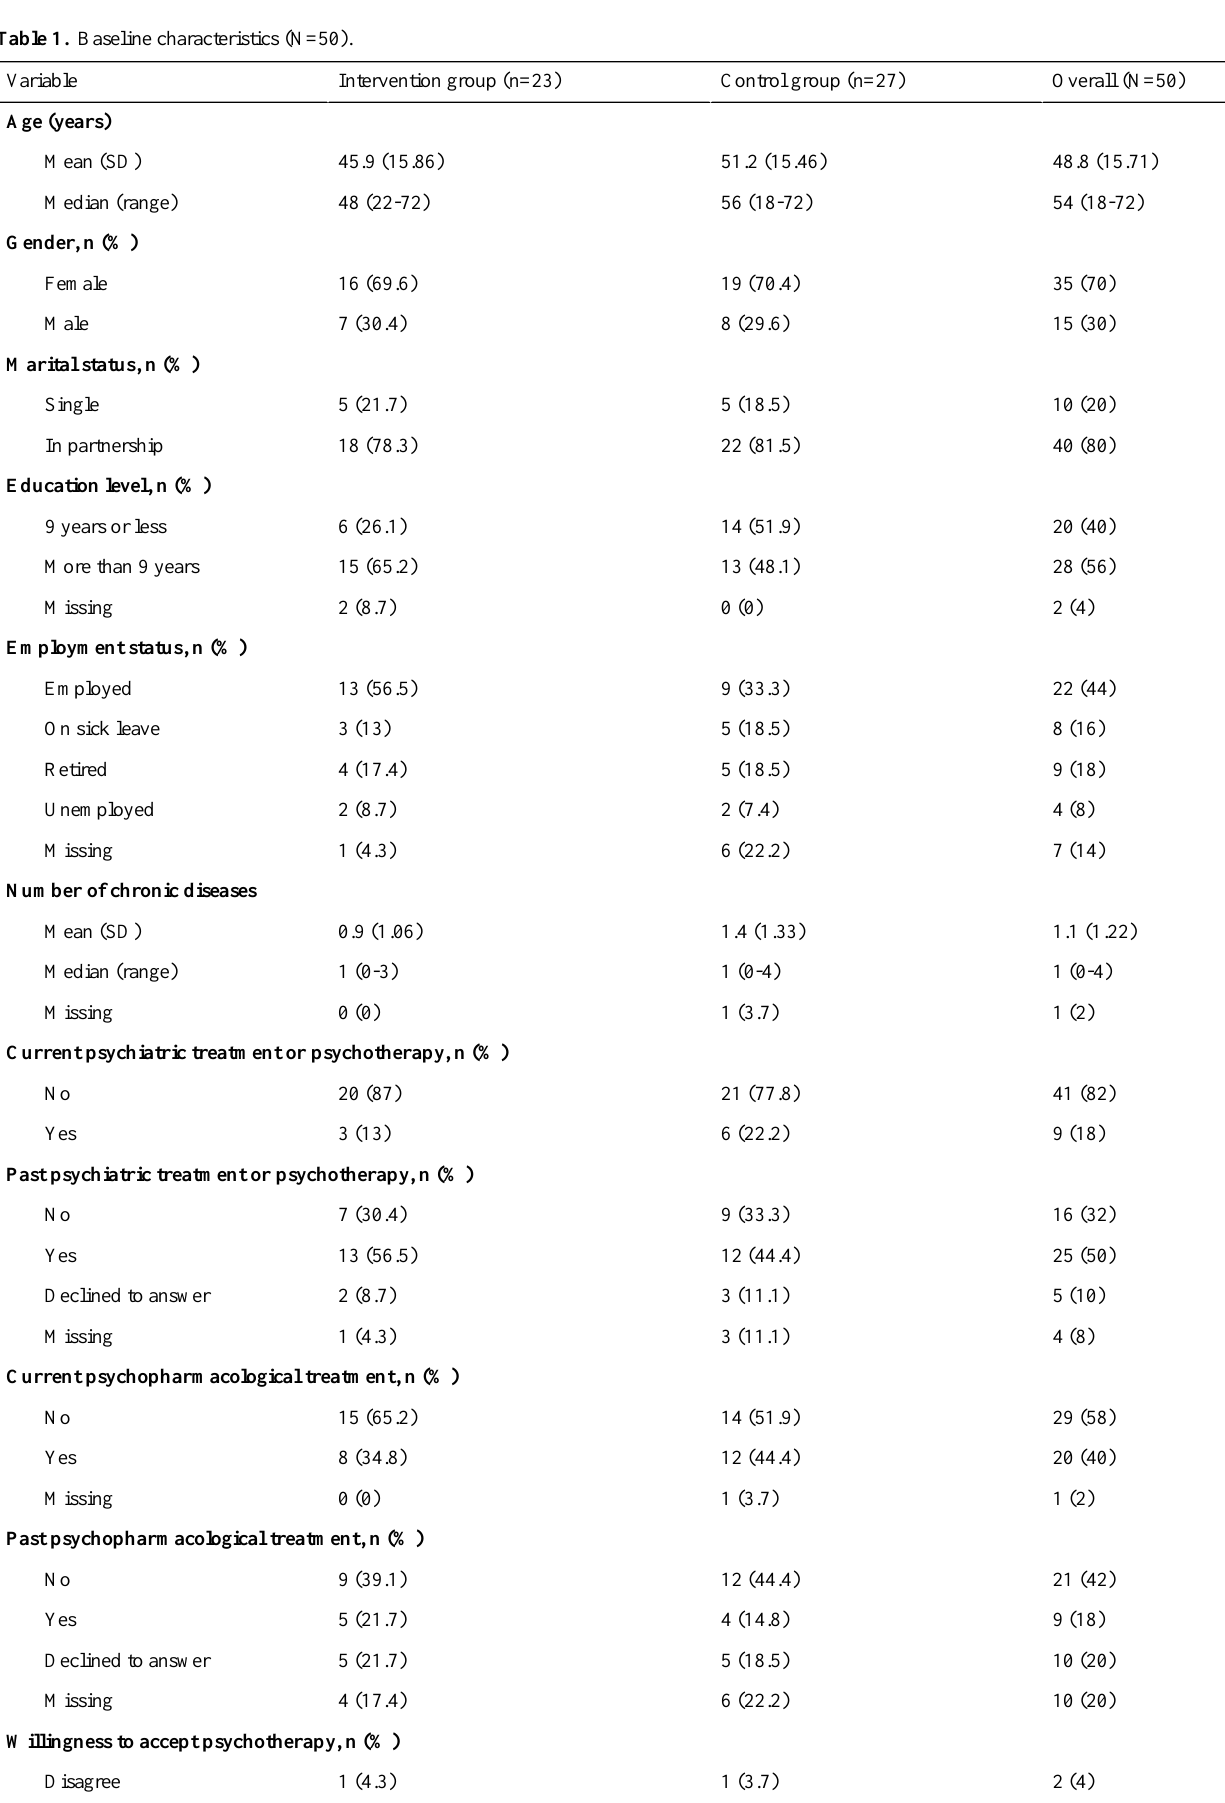
Table 1. Baseline characteristics